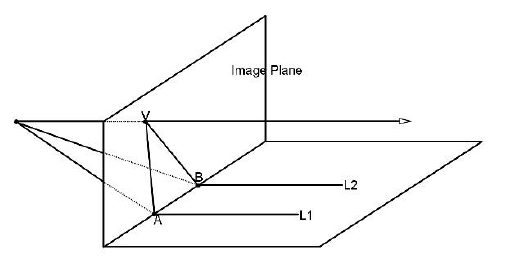
Fig 6. The center of the red circle is vanishing